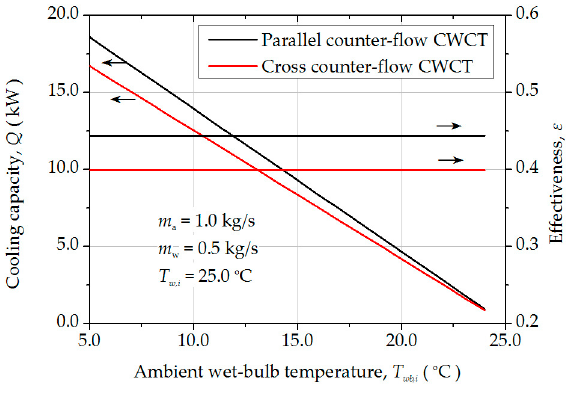
Figure 4. Cooling capacity and effectiveness versus ambient wet-bulb temperature (the arrows indicate the variable axes).